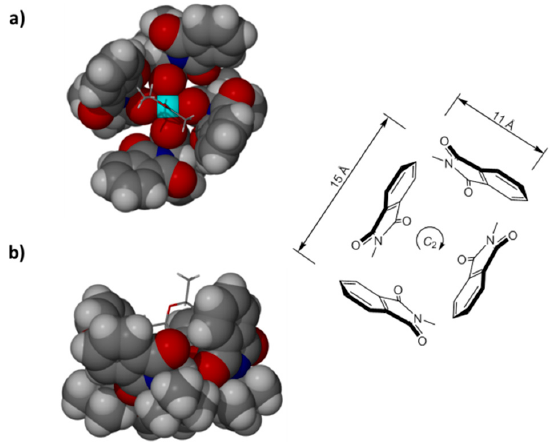
Figure 2. ( a ) Space filling structure of mono(EtOAc) adduct of Rh 2 ( S ‐ PTTL) 4 (top view); Schematic illustration of the rectangular binding pocket of Rh 2 ( S ‐ PTTL) 4 ; ( b ) Space filling structure of mono(EtOAc) adduct of Rh 2 ( S ‐ PTTL) 4 (side view). (Adapted from Adly, F.G.; Gardiner, M.G.; Ghanem, A. Chem. Eur.